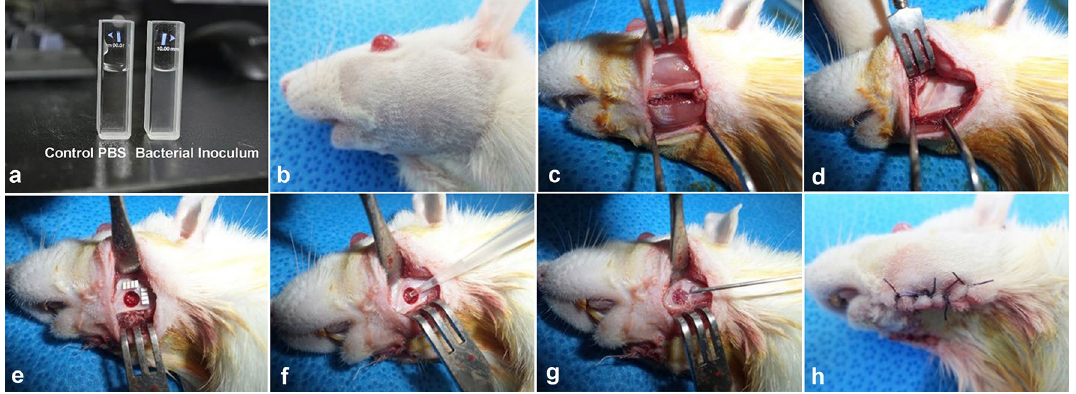
Figure 1. Inoculation process with S. aureus for inducing bacterial jaw OM. A UV/VIS spectrophotometer (LAMBDA 850 + UV/Vis Spectrophotometer; PerkinElmer, Waltham, MA, US) adjusted to an optical density 0.8 at 600 nm, that was used to measure the bacterial density for infection ( a ). The preparations for the surgical procedure including shaving, disinfection, and draping, which were all performed according to standard protocols ( b ). An approximately 12 mm full-thickness longitudinal extra-oral incision made parallel to the inferior border of the right and left side of rat mandibles. Adequate subcutaneous ( c ), deep fascial and periosteal dissections were performed followed by retraction with forceps ( d ). Using a low-speed hand piece with 1.2 mm diameter round bur, a bilateral circular 4 mm defect was created in the rat mandible ( e ) with copious irrigation. All animals received 20 μl of 10 7 CFU/ml S. aureus injection ( f ) into the defect and were covered with fibrin glue (Greenplast Q; Green Cross, Yongin, Korea) ( g ). The surgical wound carefully sutured at the subcutaneous layer with resorbable 4-0 Vicryl (Polyglactin 910; Johnson & Johnson, Somerville, NJ, US) sutures and the skin closure was performed using silk sutures (BLACK SILK 4-0; AILEE, Busan, Korea) ( h ).